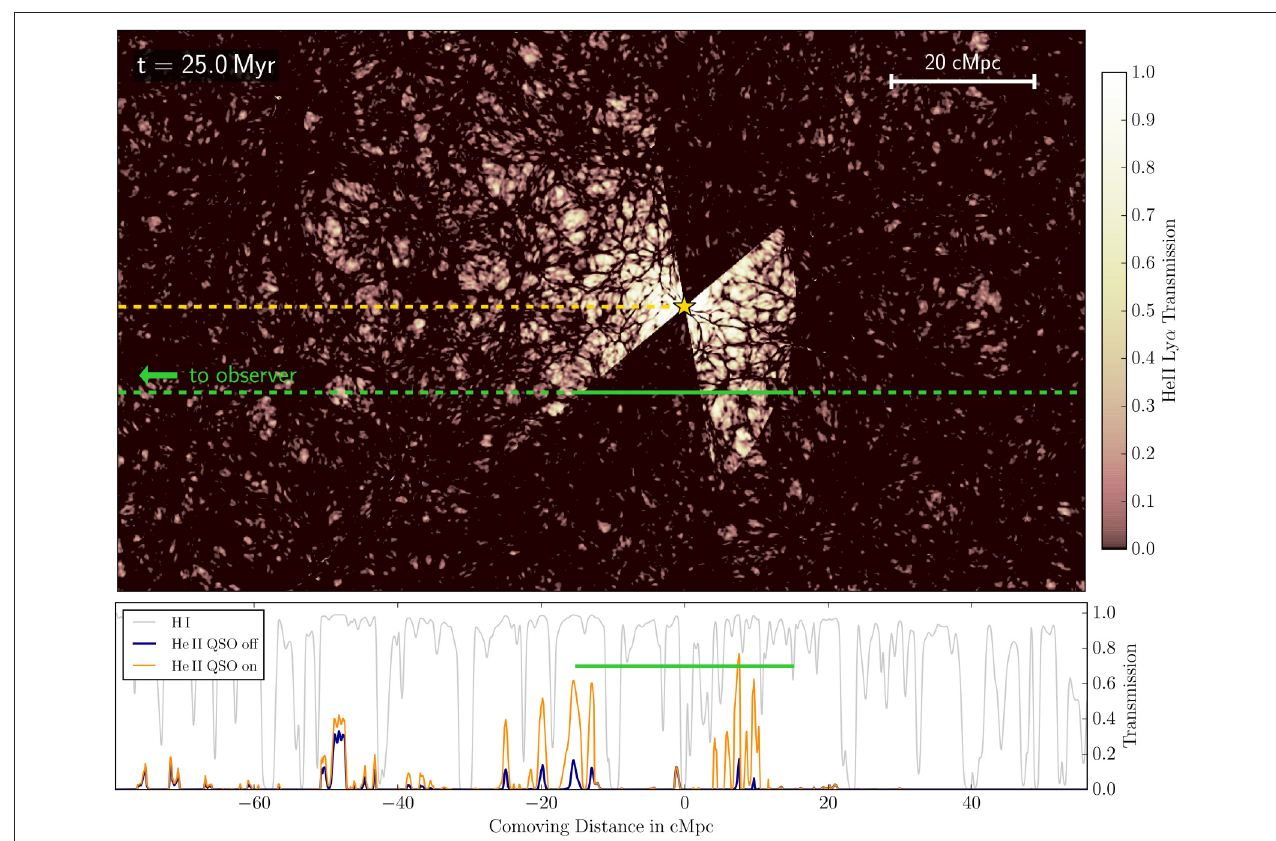
FIGURE 4 | Illustration of our photoionization model we use to investigate the effect of obscuration and finite quasar age. The top panel displays the He II transmission in a slice through the simulation box. It clearly shows the bi-conical emission of the quasar and the parabolic shaped region that can be reached by the quasar emission within the given time. The bottom panel shows the computed hydrogen and helium transmission spectra along a background sightline (green). A strong He II transmission enhancements is visible in regions that are illuminated by the quasar. The solid green bar marks the ± 15cMpc wide region we use to measure the transmission enhancement (Schmidt et al.,